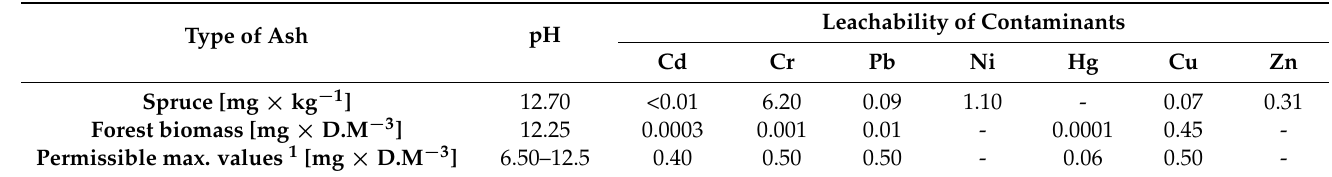
Table 4. Examples of the results of determinations of basic components of ashes from the combustion of energy